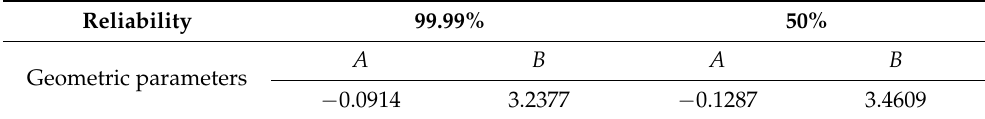
Table 6. Estimated geometric parameters of a HL-type sucker rod.